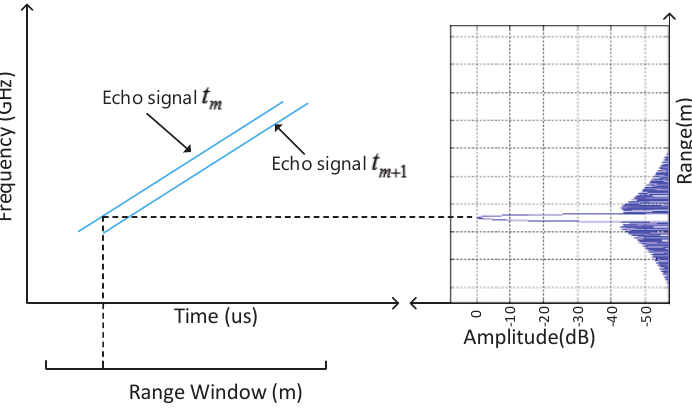
Figure 2. The “stretching” idea of the proposed cross-correlation of adjacent echoes (CCAE)